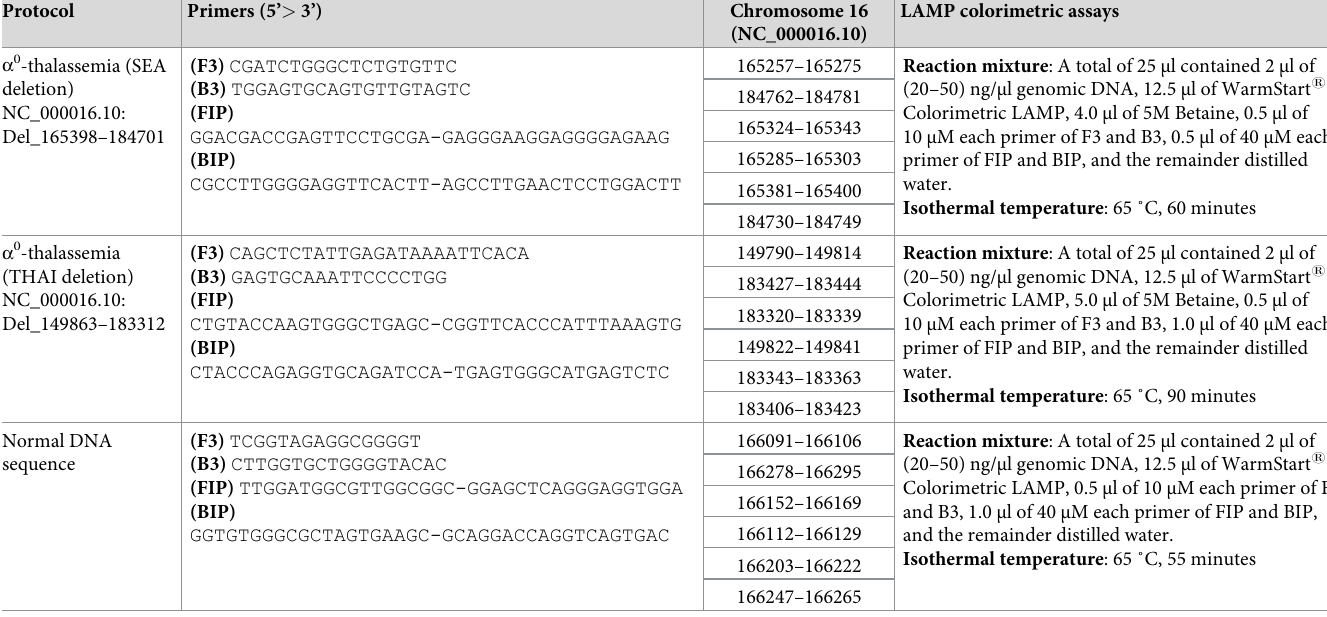
Table 1. Protocols of the LAMP colorimetric assays for α 0 -thalassemia (SEA and THAI deletions), and normal DNA sequence. Sequences of the oligonucleotide primers used in each protocol and the LAMP reaction mixtures are listed. Protocol Primers (5’ >